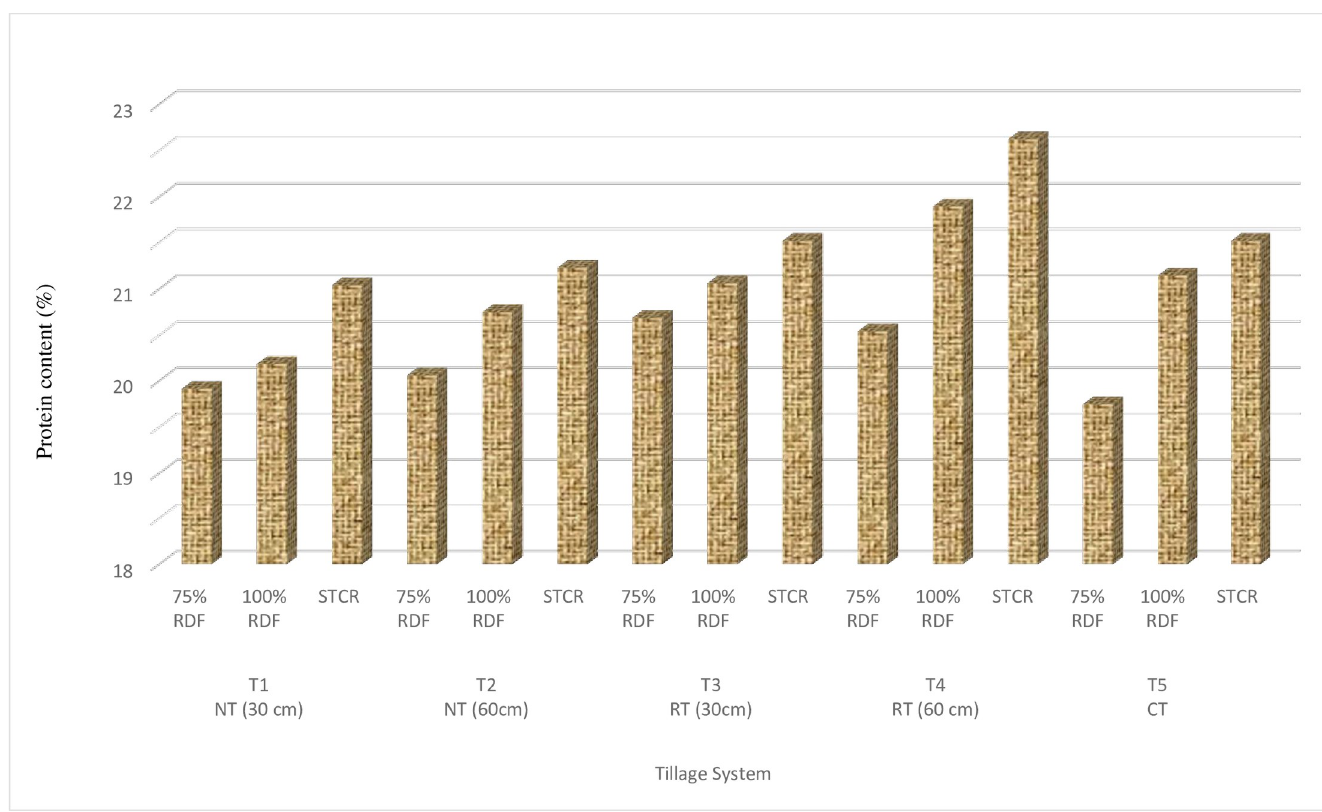
Fig 4. Effect of tillage practices, crop residue management and nutrient levels on seed protein content. (T 1 —NT with 30cm residue height; T 2 —NT with 60cm residue height; T 3 —RT with 30cm residue height; T 4 —RT with 60cm residue height; T 5 –Conventional Tillage).